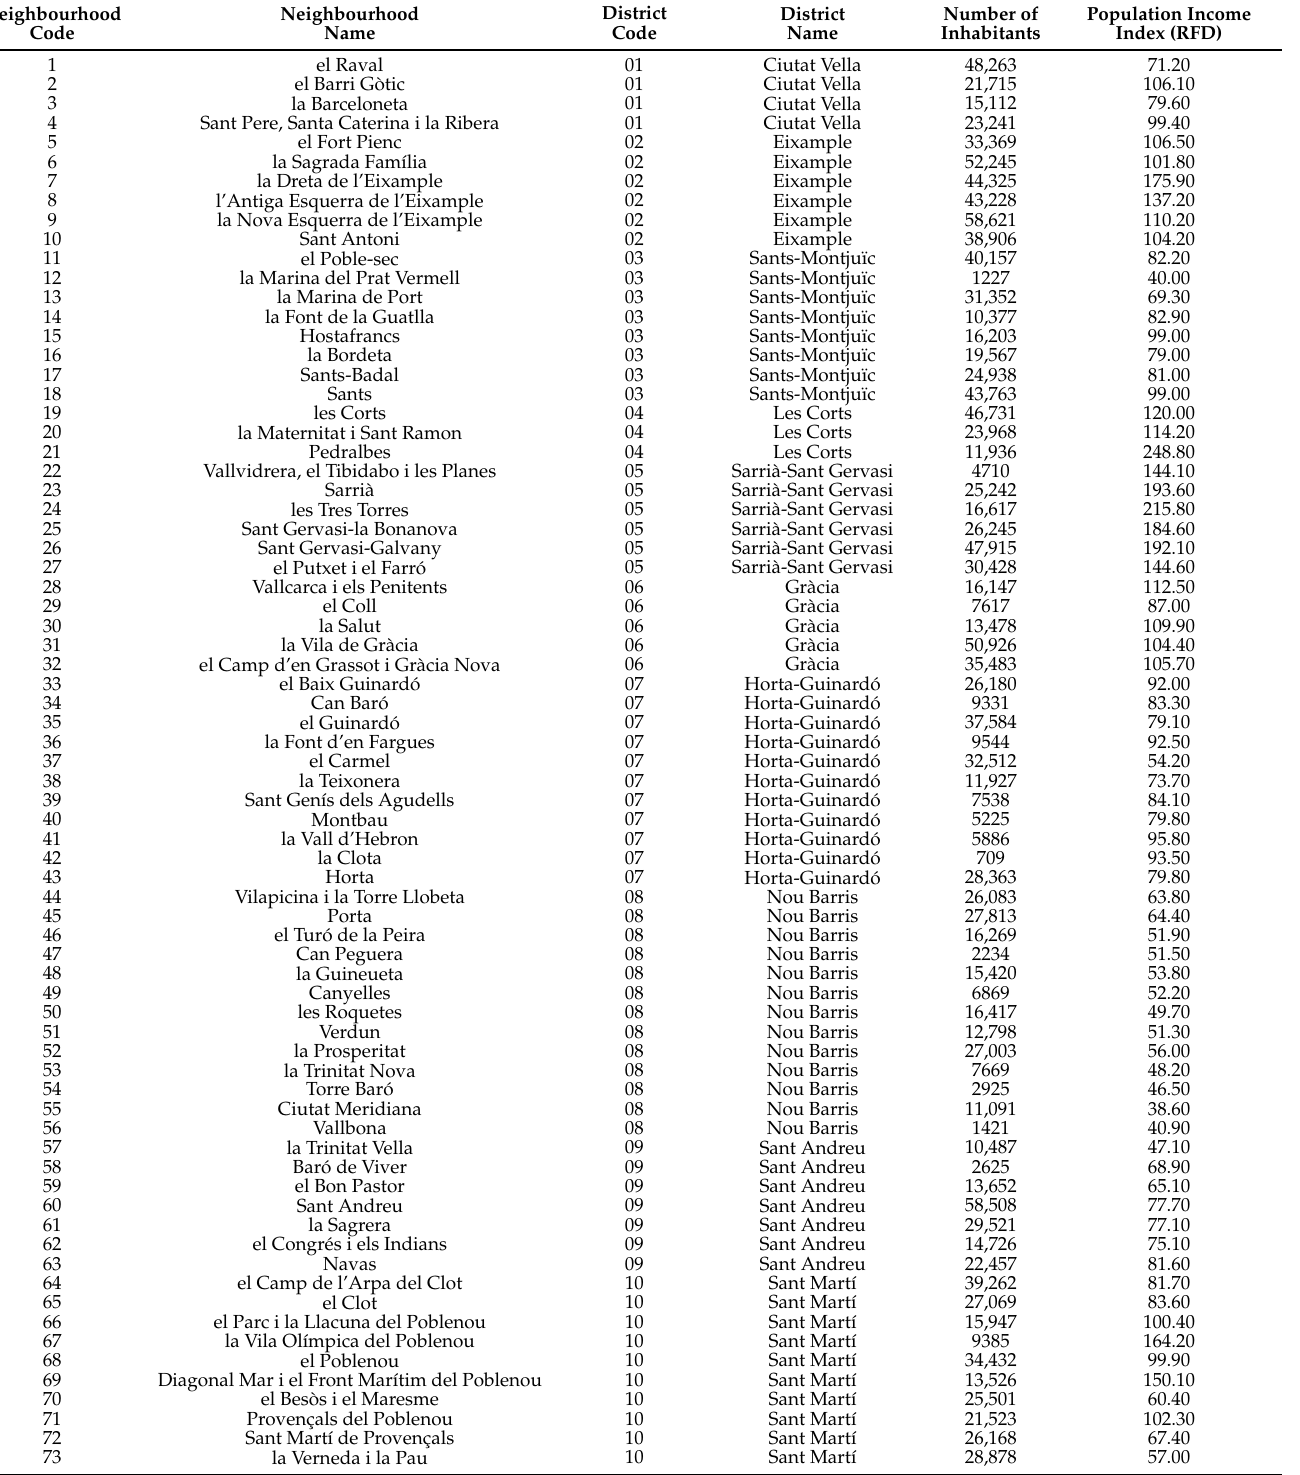
Table A1. This table shows the district, number of residents, income and surface area for each of Barcelona’s 73 neighbourhoods. The population income index (RFD) represents the average level of family income available per capita of the inhabitants of the neighbourhood in relation to the Barcelona average (Index